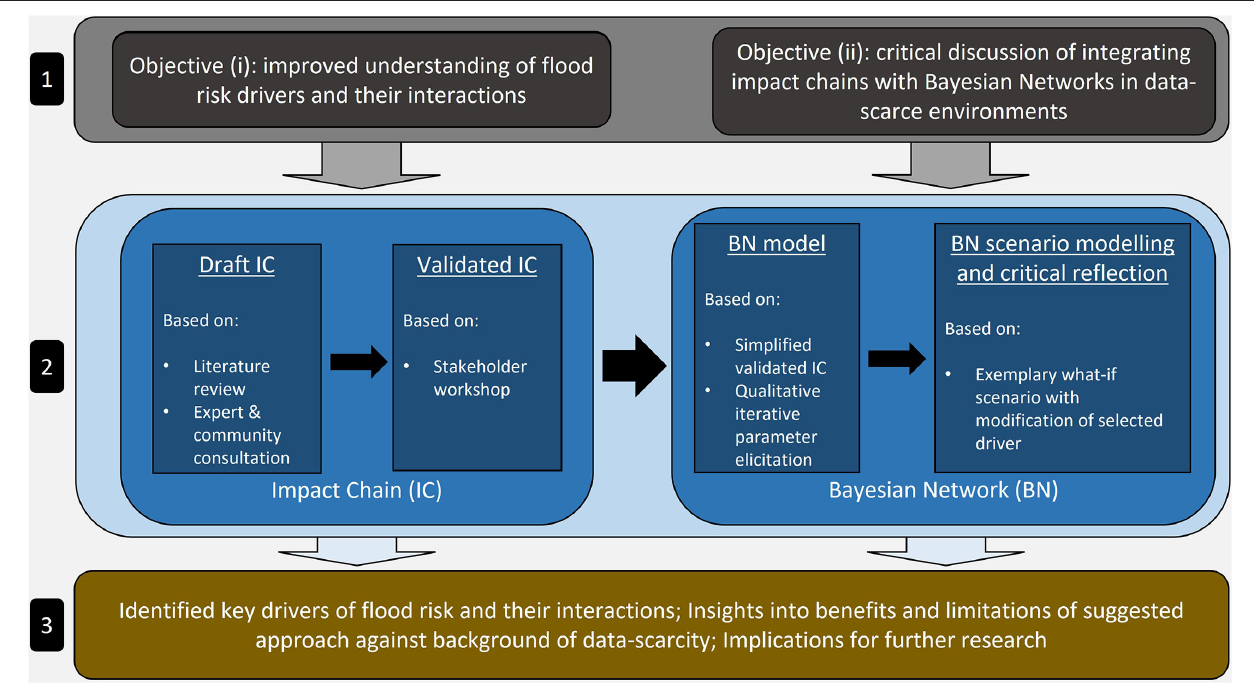
FIGURE 1 | Context of methodological approach. 1: objectives; 2: methodology; 3: outcome.